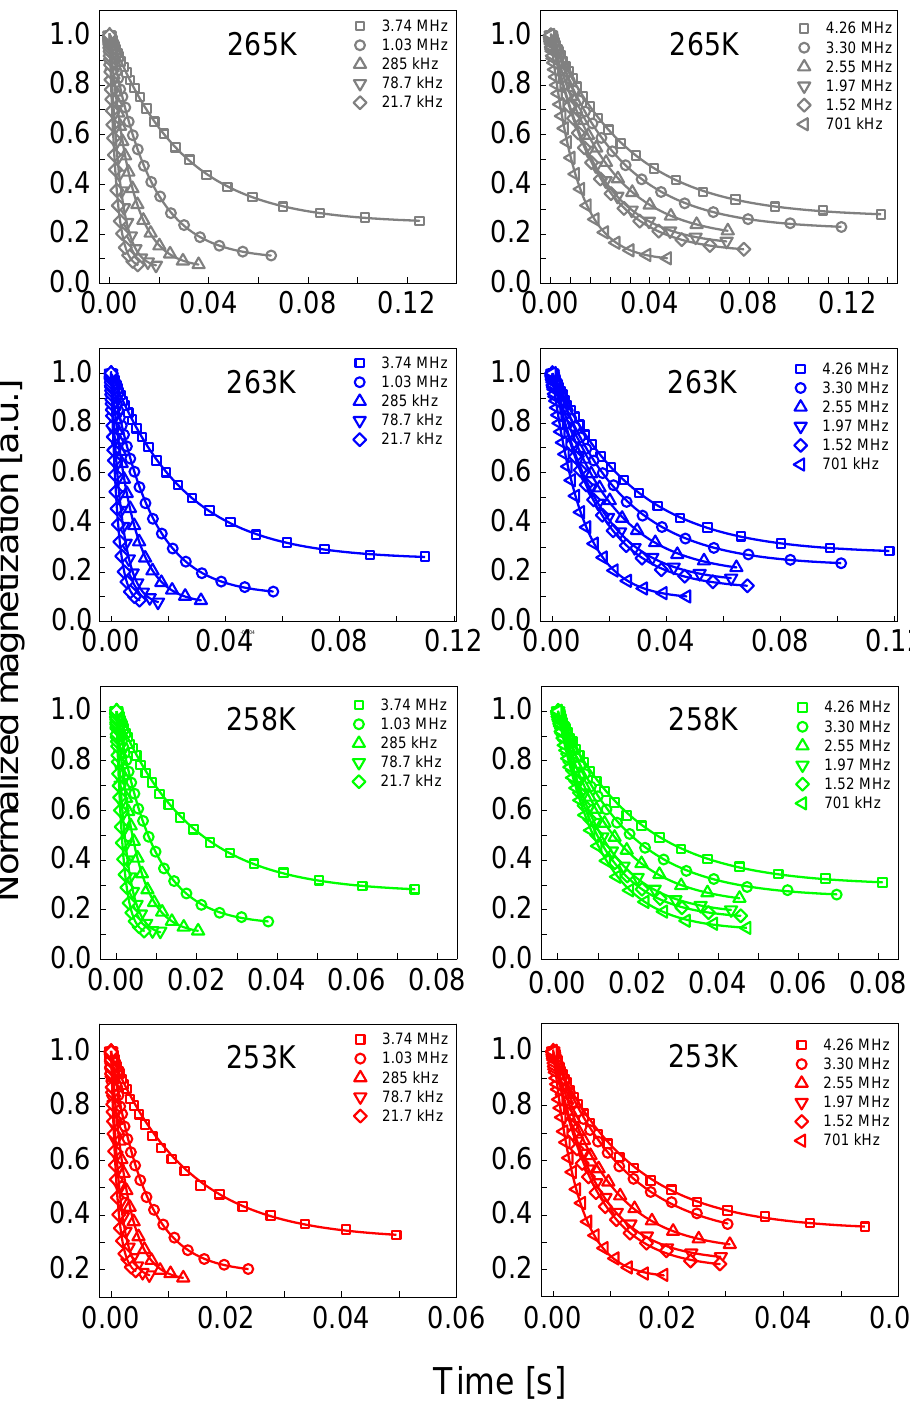
Figure A4. Normalized 1 H magnetization curves for BSA–water mixture (40%wt BSA) at selected resonance frequencies in the temperature range from 263 K to 253 K. Solid lines—single exponential fits. The frequencies are selected from the entire range measured.